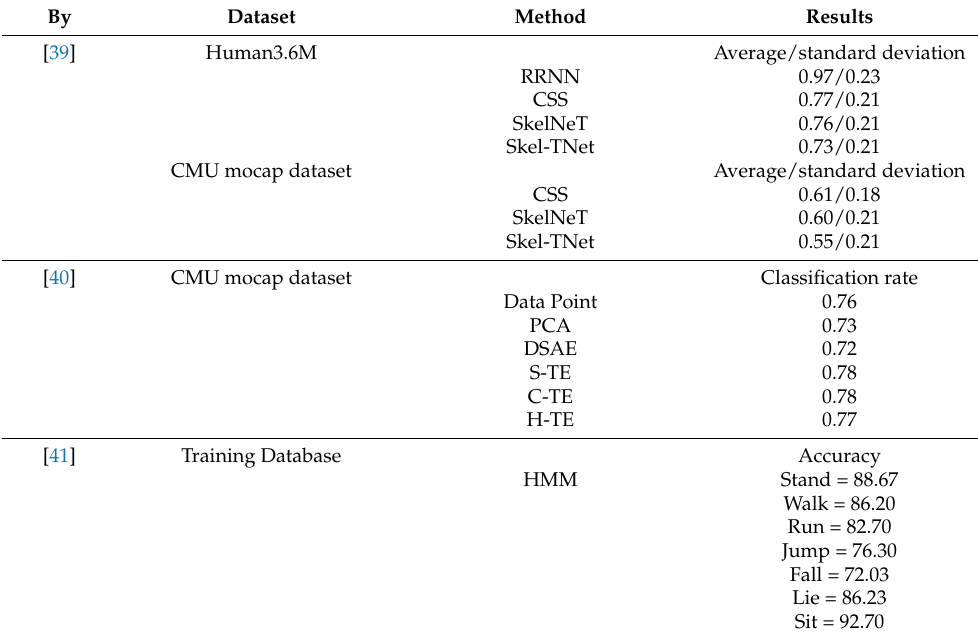
Table 3. The evaluation results of our proposed method compared with those of similar methods applied to the Mocap